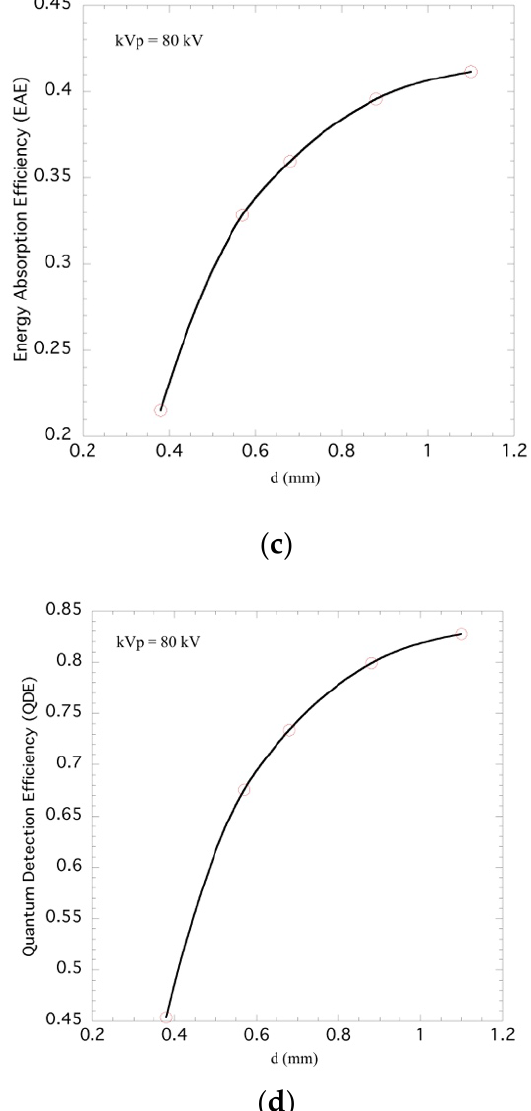
Figure 5. ( a ) Energy absorption efficiency (EAE) of Gd 2 O 2 S powder screens as a function of X-ray tube voltages. ( b ) Quantum detection efficiency (QDE) of Gd 2 O 2 S powder screens as a function of X-ray tube voltages. Points correspond to calculated values (from 50 kVp to 130 kVp). All screens with the same thickness d = 0.38 mm gave the same results, so the points in the figure are superimposed. ( c ) Energy absorption efficiency (EAE) as a function of the thickness. ( d ) Quantum detection efficiency (QDE) as a function of the thickness. The solid lines in the graphs are guides for the eyes. Figure 6 shows the optical photon emission spectra of Gd 2 O 2 S:Tb, Gd 2 O 2 S:Pr, and Gd 2 O 2 S:Pr,Ce,F scintillator samples under X-ray excitation. Analyzing the emission spec- trum of the Gd 2 O 2 S:Tb screen, peaks are found between 475 nm and 550 nm (where the maximum is), as expected from the literature. The measured spectrum of Gd 2 O 2